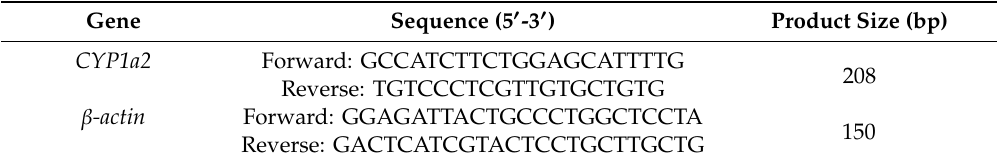
Table 1. Sequences of the primers of CYP1a2 and β